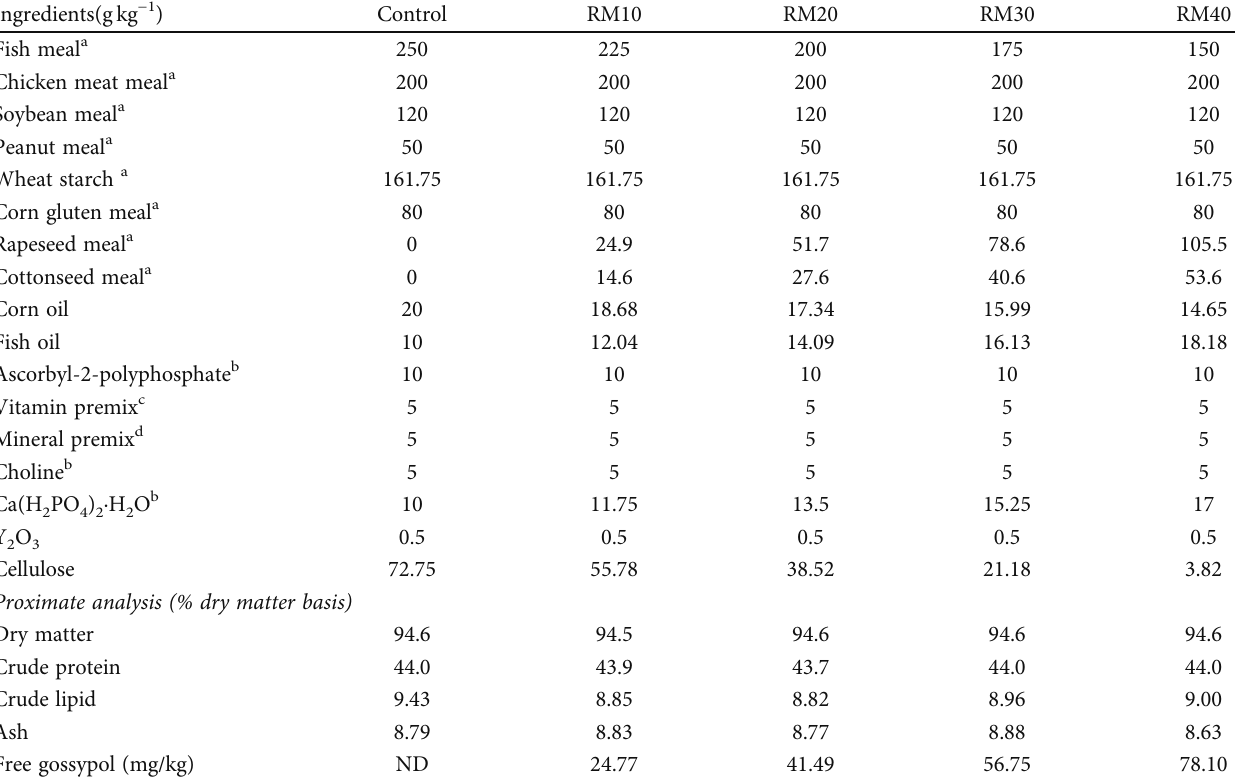
Table 1: Ingredients and proximate compositions of the experimental diets (g kg -1 dry